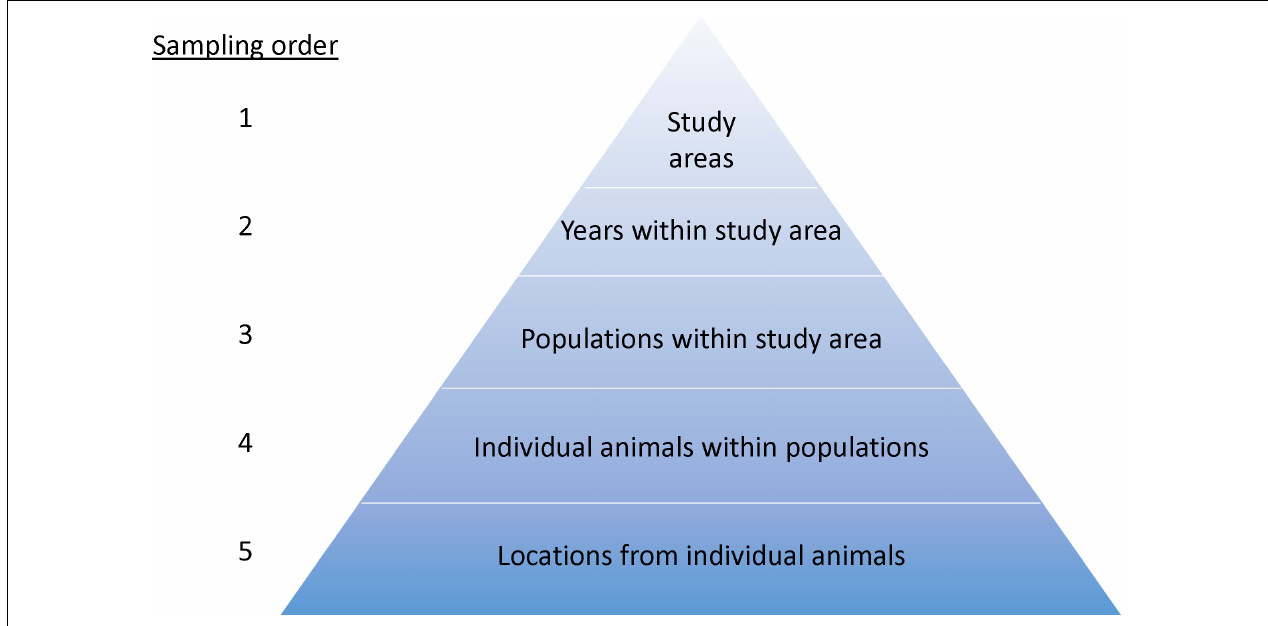
FIGURE 2 | Sampling and inference hierarchy for landscape-use modeling. Model training and testing, including estimates of precision, should replicate this order. When making inference at one level (e.g., a population), the next level in the hierarchy is the appropriate unit of replication (e.g., individual animals) for estimating precision. Estimates of precision for a single study area should consider blocking at the next available level where replication occurs. For example, if within one study area (1), multiple years are studied (2), then model evaluation should use years (2), populations (3), or individual animals (4) for blocking, depending on the available sample size at each level. Estimates for a broader landscape require a sample ( n > 1) of study areas.